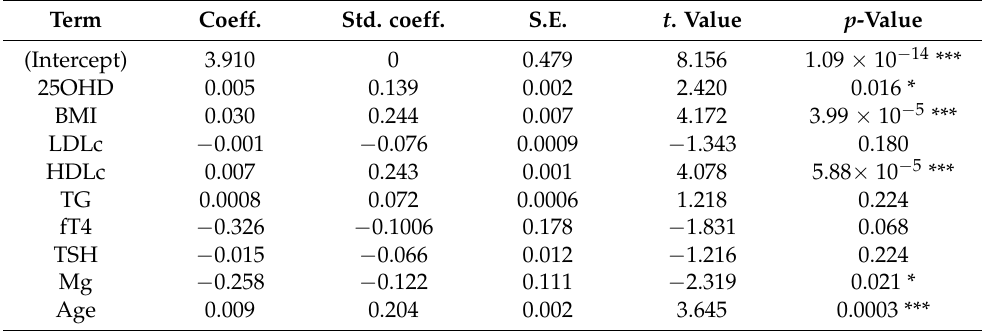
Table 4. A linear regression model describing the effects of 25OHD and several variables on HbA1c in the study sample.